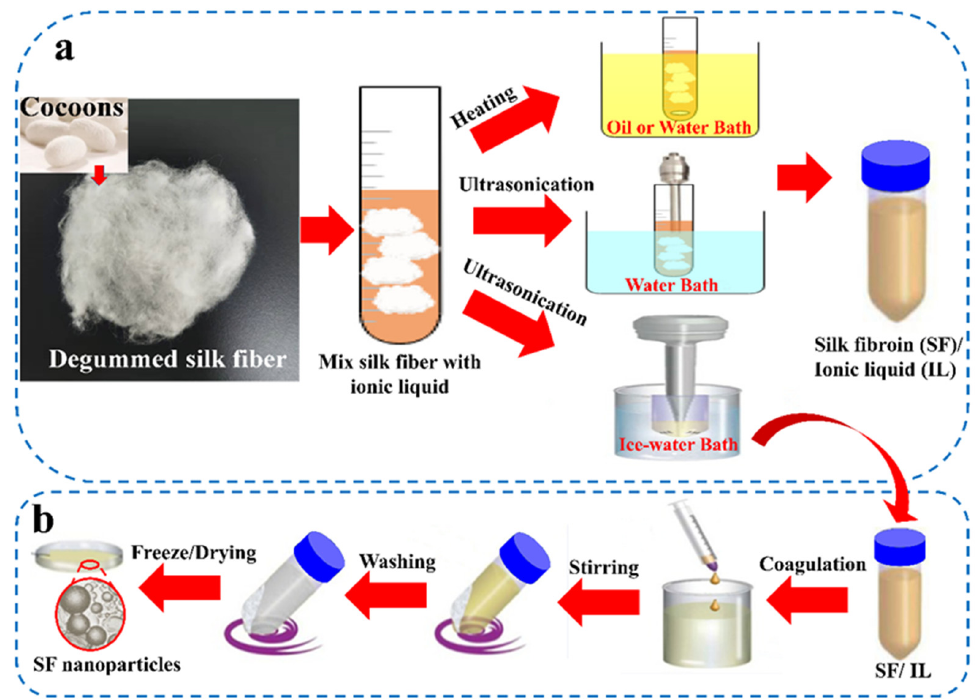
Figure 6. ( a ) Several different heating methods for dissolving SF with ILs: water or oil bath